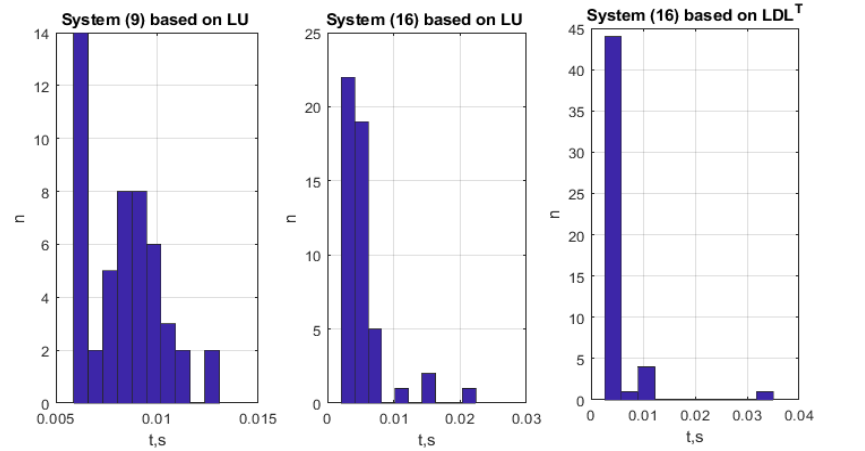
Figure 1. The step response of the system (20).